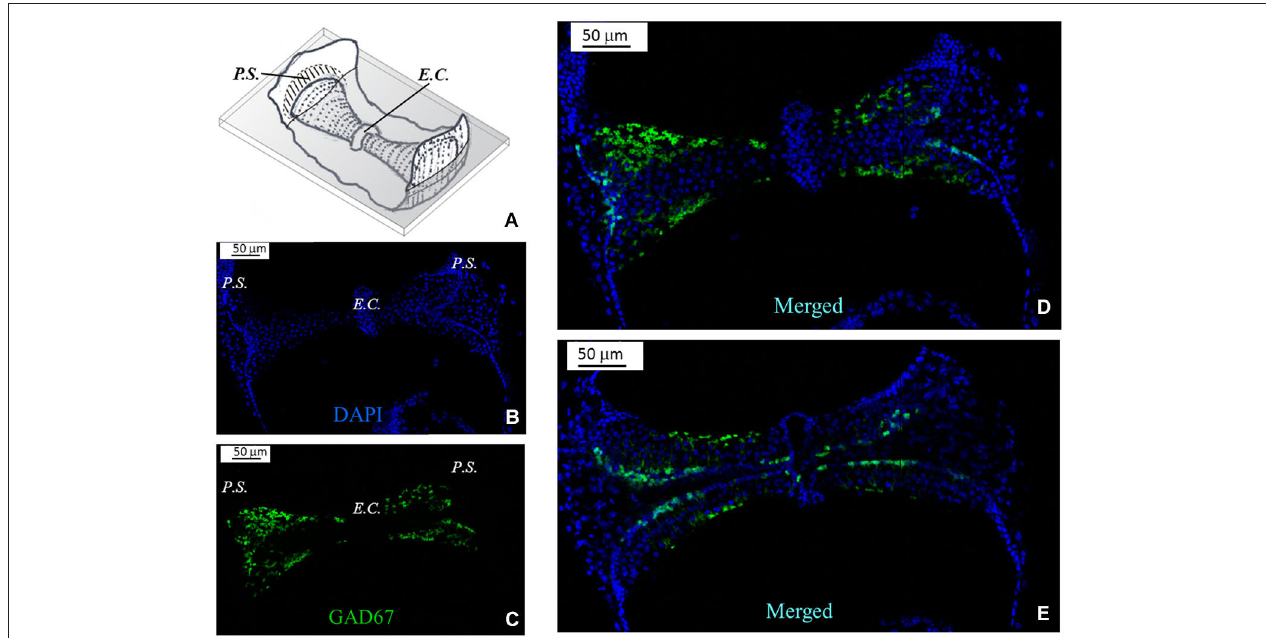
merged image, respectively. Light blue indicates co-localization of nuclei and GFP, which seems poor because GAD67 is expressed in the cytoplasm. Most cell bodies at this confocal level appear sectioned transversally. (E) Photomicrograph of a lower confocal section of the same specimen (merged image). Most cell bodies appear now sectioned longitudinally, as inferred from their elongated